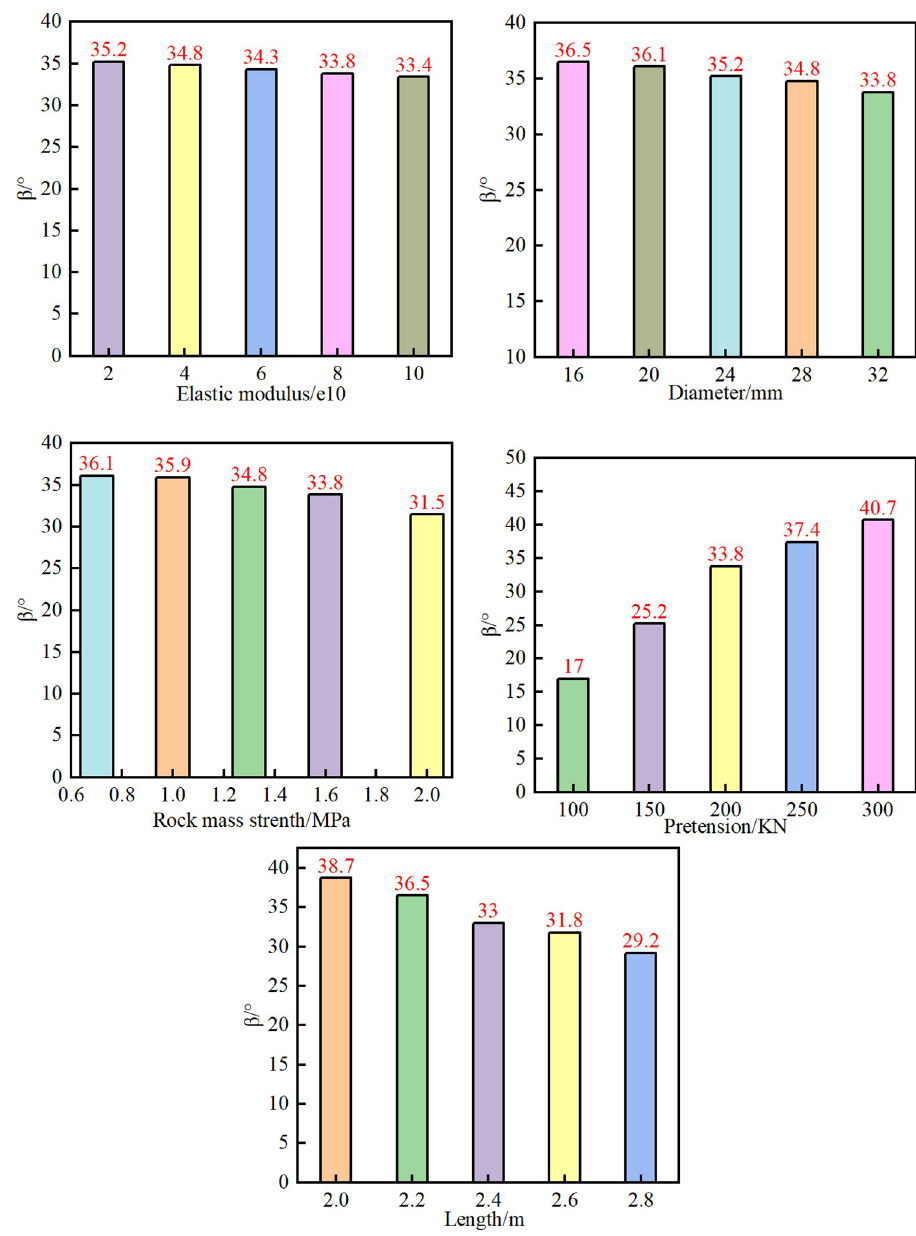
Fig 11. Influence angle β under different